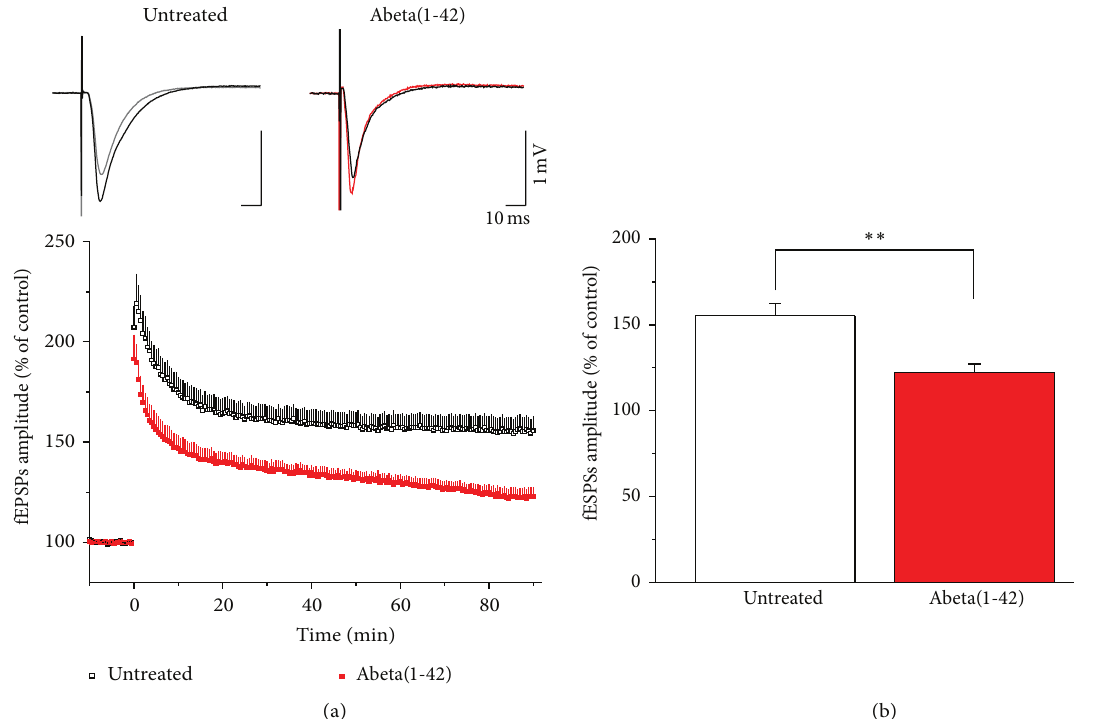
Figure 4: Abeta(1-42) impairs LTP. Representative fEPSPs from both control and Abeta(1-42) groups. Field EPSP was recorded before (grey) and 90 min after LTP induction (control is in black and Abeta(1-42) is in red) from the proximal stratum radiatum of CA1 (see above). Following 1h of Abeta(1-42) treatment, LTP was induced by TBS protocol. LTP was reduced in Abeta(1-42) treated slices compared to controls 90 min after TBS (untreated versus Abeta: 𝑃 = 0.002 ) (a). The amplitudes of fEPSPs after TBS were normalized to pre-TBS control. Bar graphs show the average of the last 5 min of LTP. Error bars represent SEM; ∗∗ 𝑃 ≤ 0.01